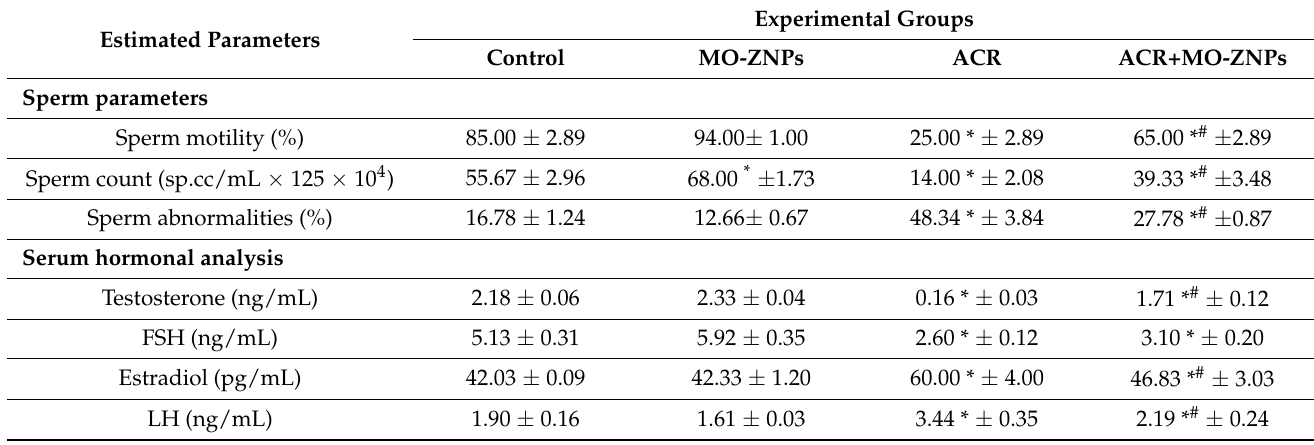
Table 3. Effect of green synthesized zinc oxide nanoparticles produced by Moringa Oleifera leaf extract (MO-ZNPs) on sperm parameters and serum hormone levels of acrylamide (ACR)-exposed rats.